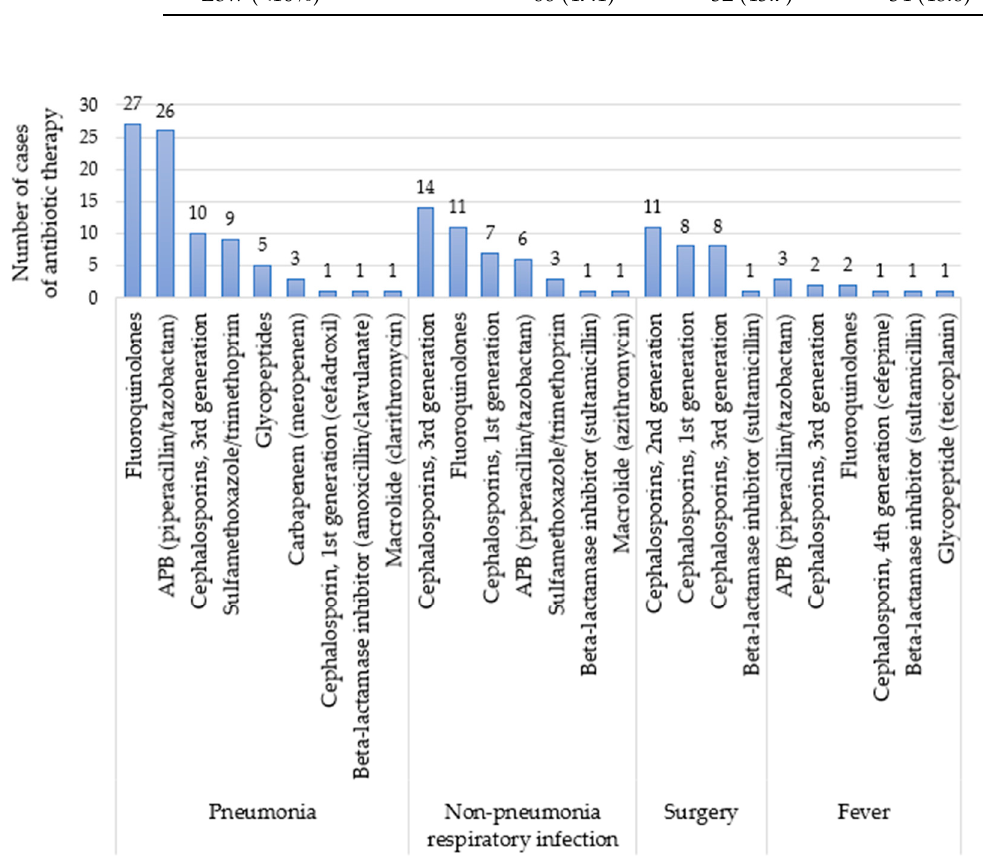
Figure 1. Antibiotic use by class for the four most frequent conditions reported. Abbreviation: APB, anti-pseudomonal beta-lactamase inhibitor.